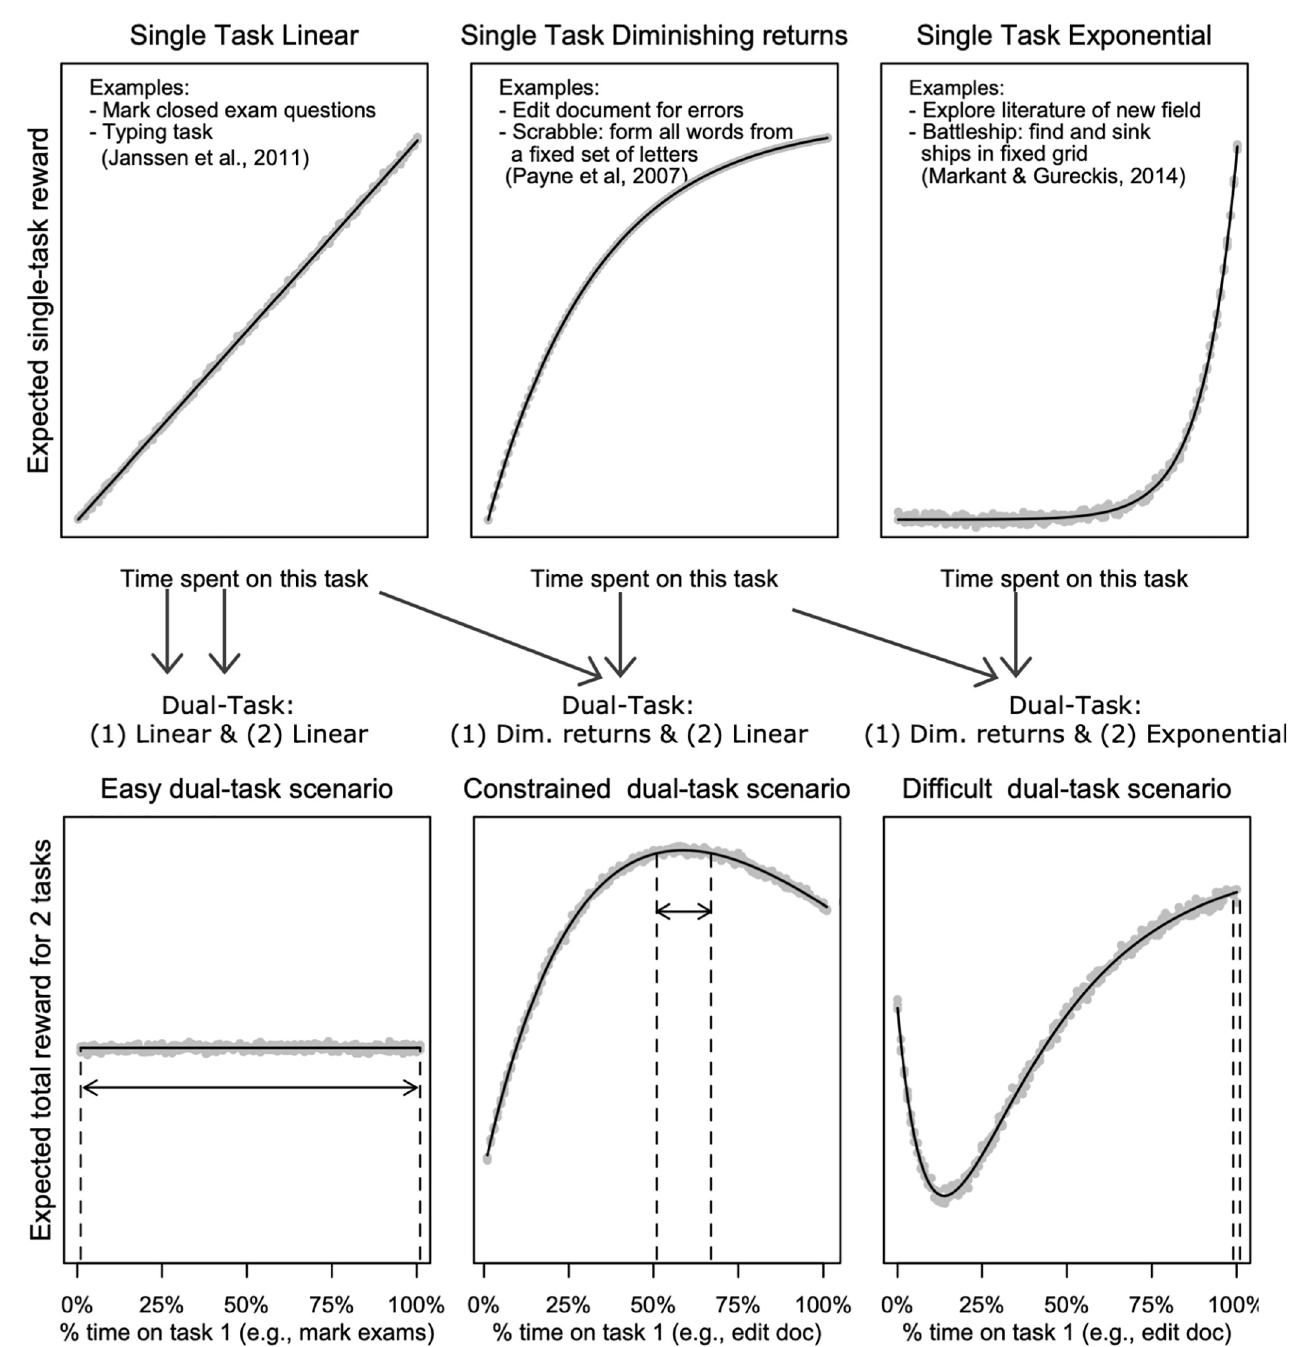
Fig 1. Illustration of the general problem. Top: Single-tasks differ in their underlying reward functions. Bottom: Different dual-task scenarios emerge from different task combinations. Black lines show mean expected rewards of random trials (grey dots) given the strategy (time on task). Strategies within the dashed lines achieve optimal rewards (within 1% of maximum). The combination of single-tasks into dual-tasks impacts the a priori chance of finding an optimum interleaving strategy.